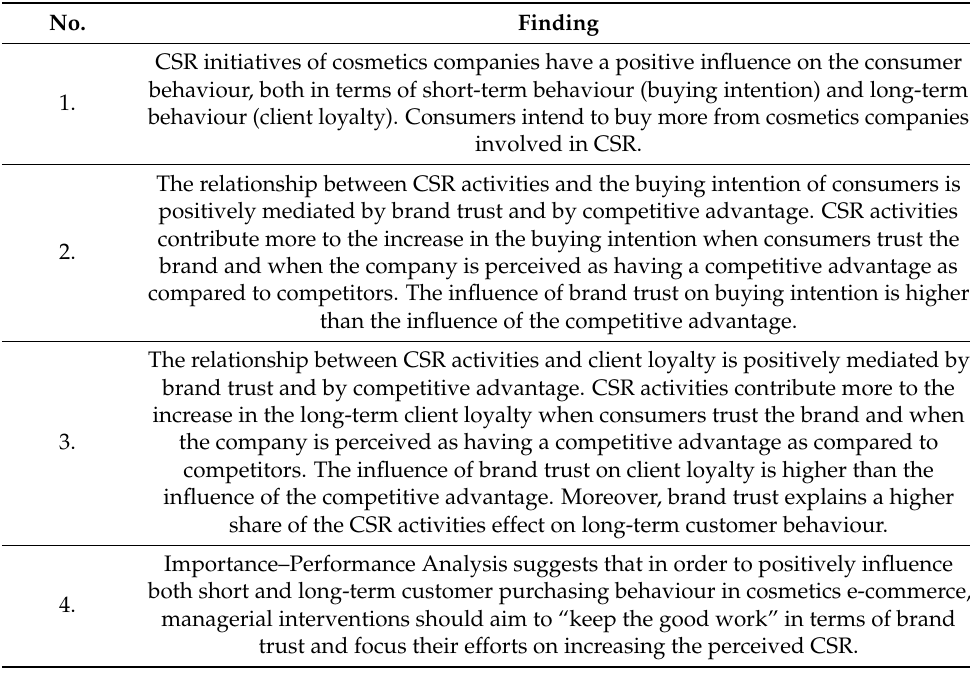
Table 9. Summary of main